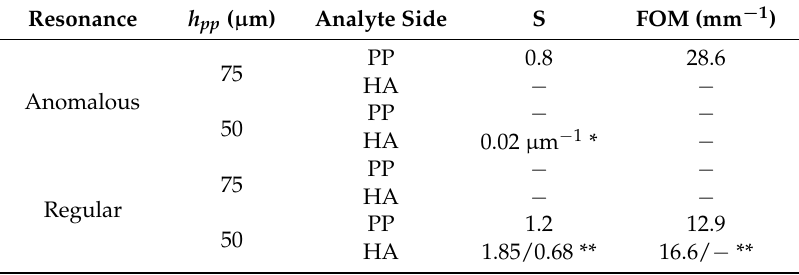
Table 1. Average sensitivity and FOM achieved in the configurations shown in Figures 3 and 4, experimental